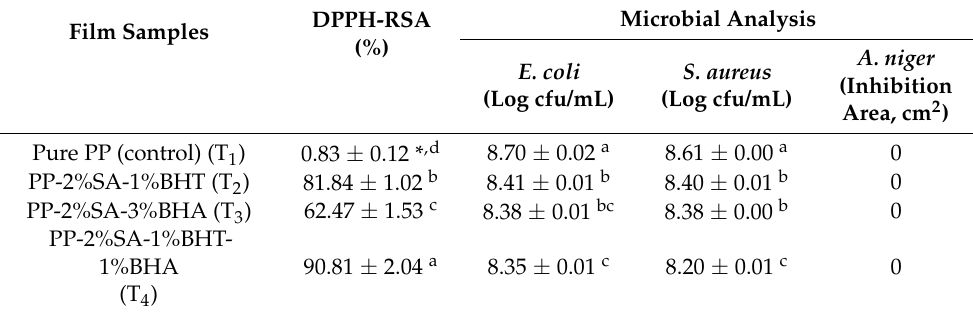
Table 5. The results of antioxidant capacity expressed as 2,2-diphenyl-1-picrylhydrazyl (DPPH) radi- cal scavenging activity (RSA), and antimicrobial properties of PP-based composite films incorporating a different combination of antioxidants/antimicrobials. Microbial Analysis DPPH-RSA Film Samples (%) A. niger E. coli S. aureus (Inhibition (Log cfu/mL) (Log cfu/mL) Area, cm 2 ) Pure PP (control) (T 1 ) 0.83 ± 0.12 * ,d 8.70 ± 0.02